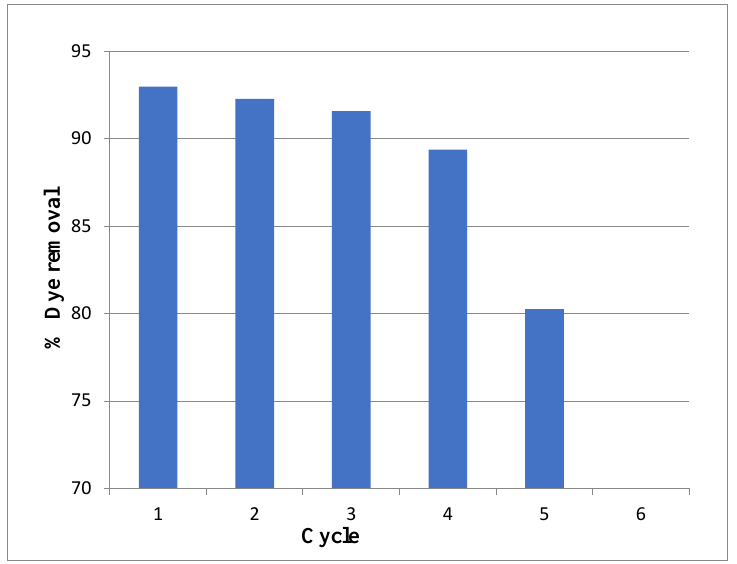
Figure 19. Cyclic adsorption performance of Fe 3 O 4 /CA.